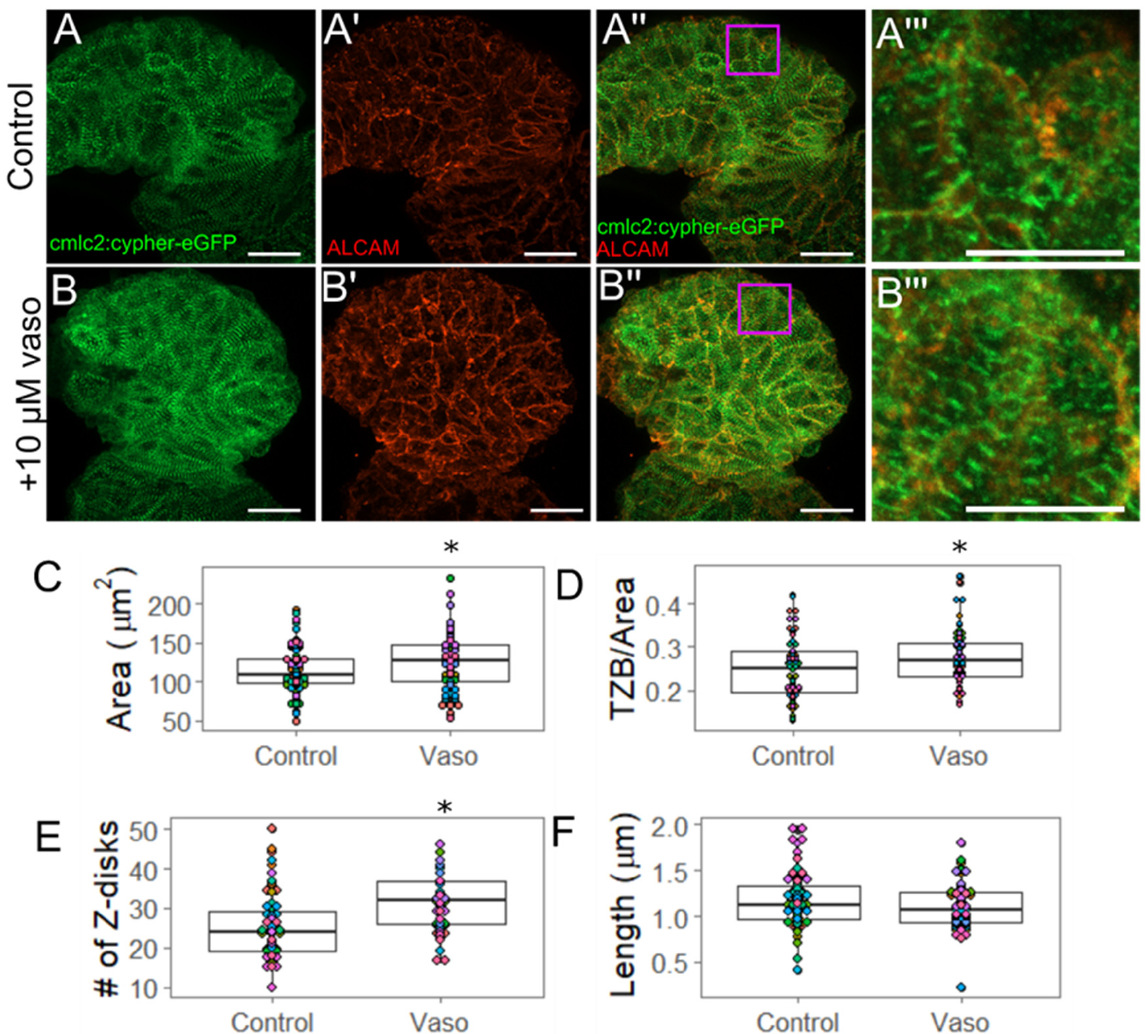
Figure 3. Increased pressure causes hypertrophy of ventricular outer curvature (OC) myocytes by 56 hpf. ( A ) Control and ( B ) vaso-treated hearts showing z-disks ( A , B ) and cell shape through AL- CAM immunohistochemistry ( A ′ , B ′ ). A ′′ and B ′′ display merged images. Purple box shows regions of interest shown in A ′′′ and B ′′′ . For A – A ′′ , and B – B ′′ , scale bar represents 20 µm. ( A ′′′ ) Control and ( B ′′′ ) vaso-treated hearts. Scale bar represents 10 µm. ( C ) Area of ventricular OC cells in control and vaso-treated hearts. ( D ) Total z-disk size (TZB) of sarcomeres present in each cell normalized to the area of each cell (1/µm). For details for how TML was measured, see supplemental Figure S11. ( E ) Number of z-disks per cell in control and vaso-treated hearts. ( F ) Average length of the sarcomeres present in each cell. For control and vaso-treated hearts, 14 fish were analyzed. Five cells from the OC were analyzed per fish, such that 70 total cells were analyzed. Each colored dot on the graph above represents an individual fish. * indicates p < 0.05, Student’s t -test was used for statistical com- parisons.